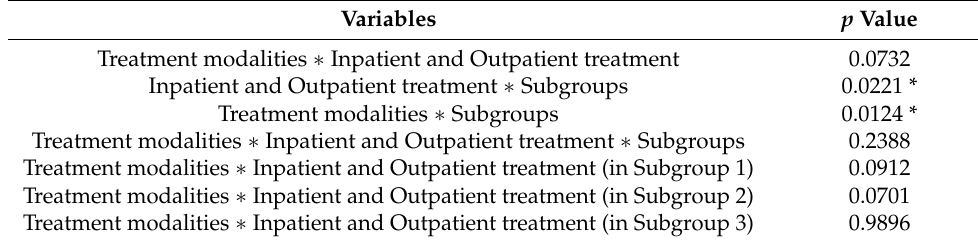
Table 2. Repeated measures ANOVA for variables.